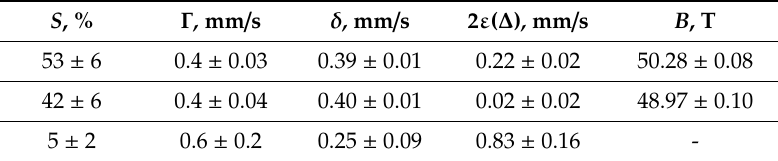
Table 1. Mössbauer spectra parameters. S , Γ , δ , 2 ε ( ∆ ), B are relative intensity, line width, isomer shift relative to α -Fe at room temperature, quadrupole shift (splitting) and hyperfine field, respectively.